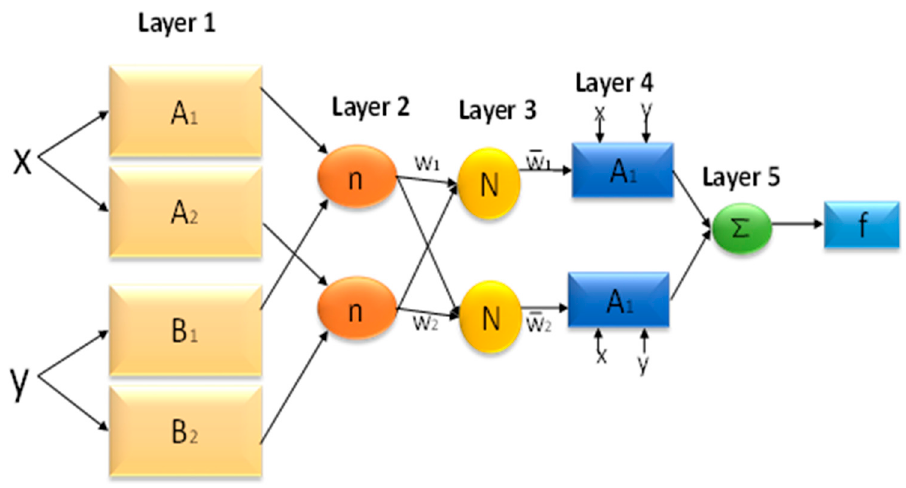
Figure 6. Architecture of the ANFIS model.